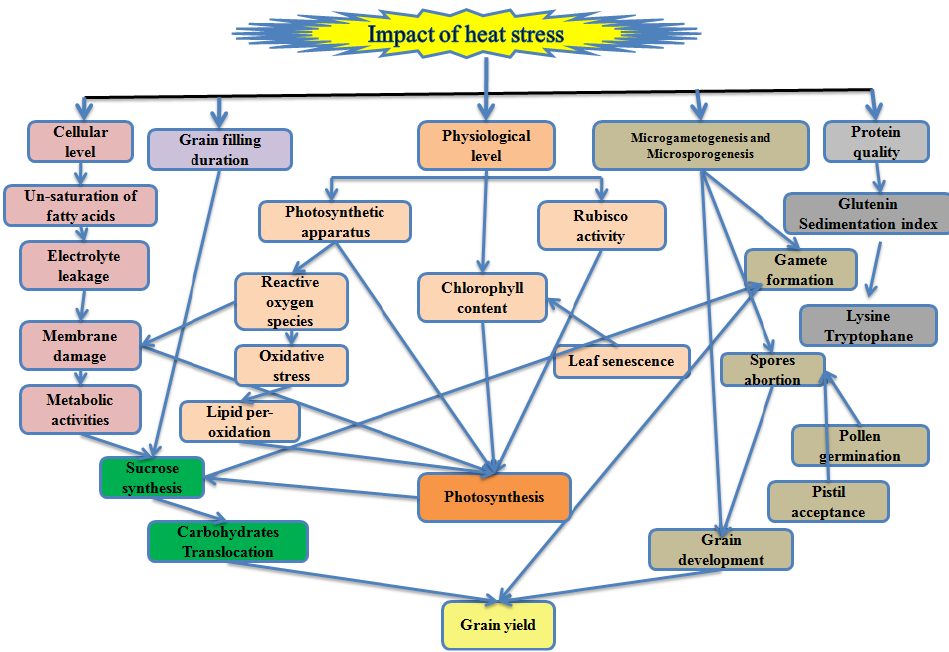
Figure 1. Schematic illustration of the high temperature impact on wheat associated with the grain yield.